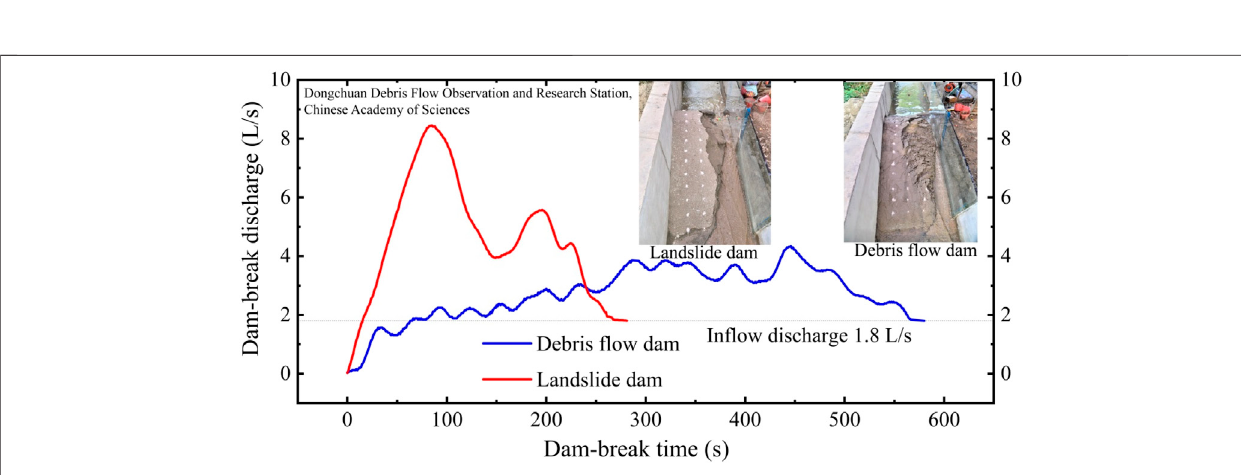
FIGURE 7 | Comparison of the dam-break discharge between a debris- fl ow dam and a landslide dam.